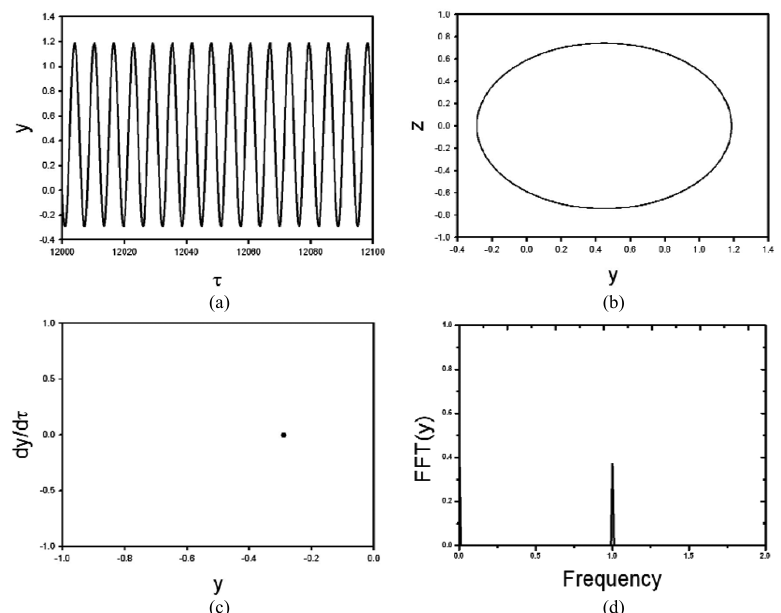
Fig. 16. Dynamic characteristic of the y-displacement of the mid-span point with γ m = 2000 T 2 m/H. (a) Time history; (b) Orbital trajectory; (c) Poincar´e section; (d)